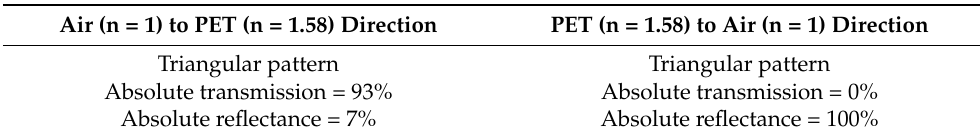
Table 3. Total transmittance and reflectance for the triangle texturization pattern, obtained for wavelength λ = 589 nm for PET foil (based on [132]).